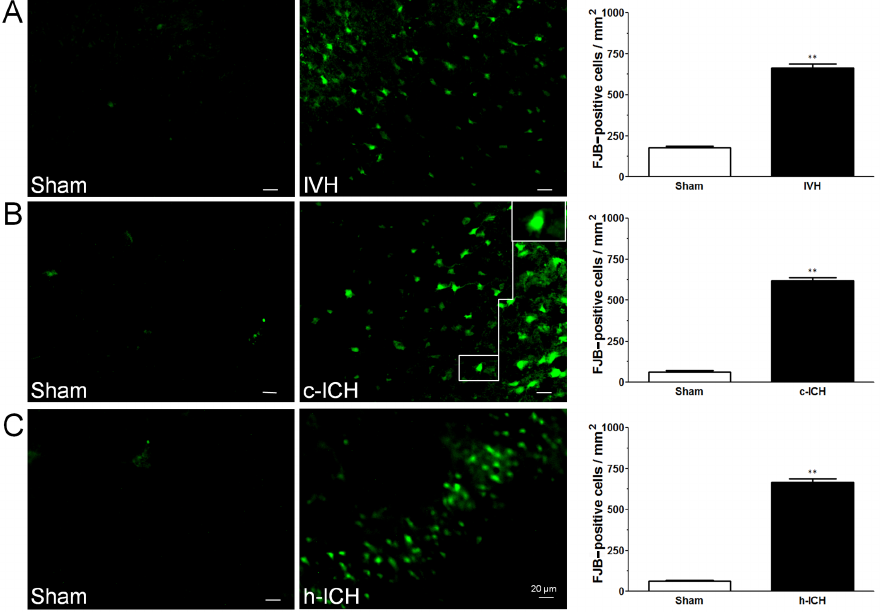
Figure 6. Neuronal degeneration is observed 72 h after intracerebral hemorrhage (ICH) in ventricle, cortex, and hippocampus. Fluoro-Jade B (FJB) staining was used to detect neuronal degeneration. FJB-positive cells were increased in the brain regions around the lateral ventricles 72 h after intraventricular hemorrhage (IVH; A) and in the perihematomal regions of the frontal cortex (B) and hippocampus (C) 72 h after cerebral ICH (c-ICH) and hippocampal ICH (h-ICH), respectively. Quantification analysis showed that the number of FJB-positive cells in the IVH, c-ICH, and h-ICH groups was significantly greater than that in the respective sham groups (n=4 mice per group). Scale bar = 20 m m. Values are means 6 SD; ** p , 0.01, t-test.